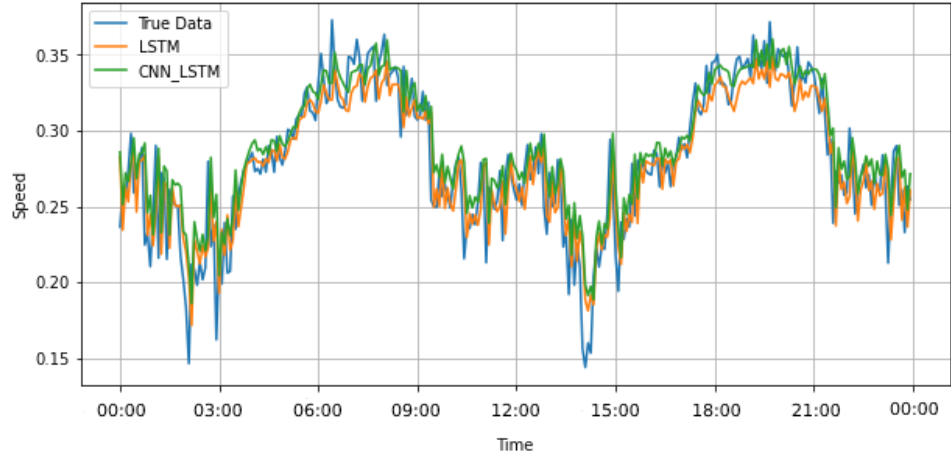
Figure 8. Prediction performance comparison among the different models under study over a 24 h horizon on the traffic speed